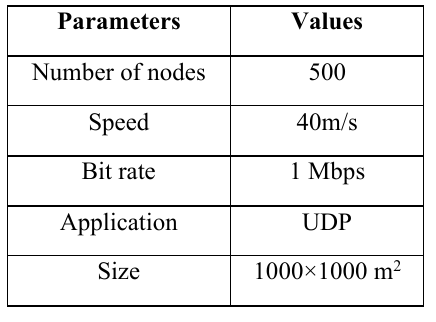
Figure 2. Process of GWO